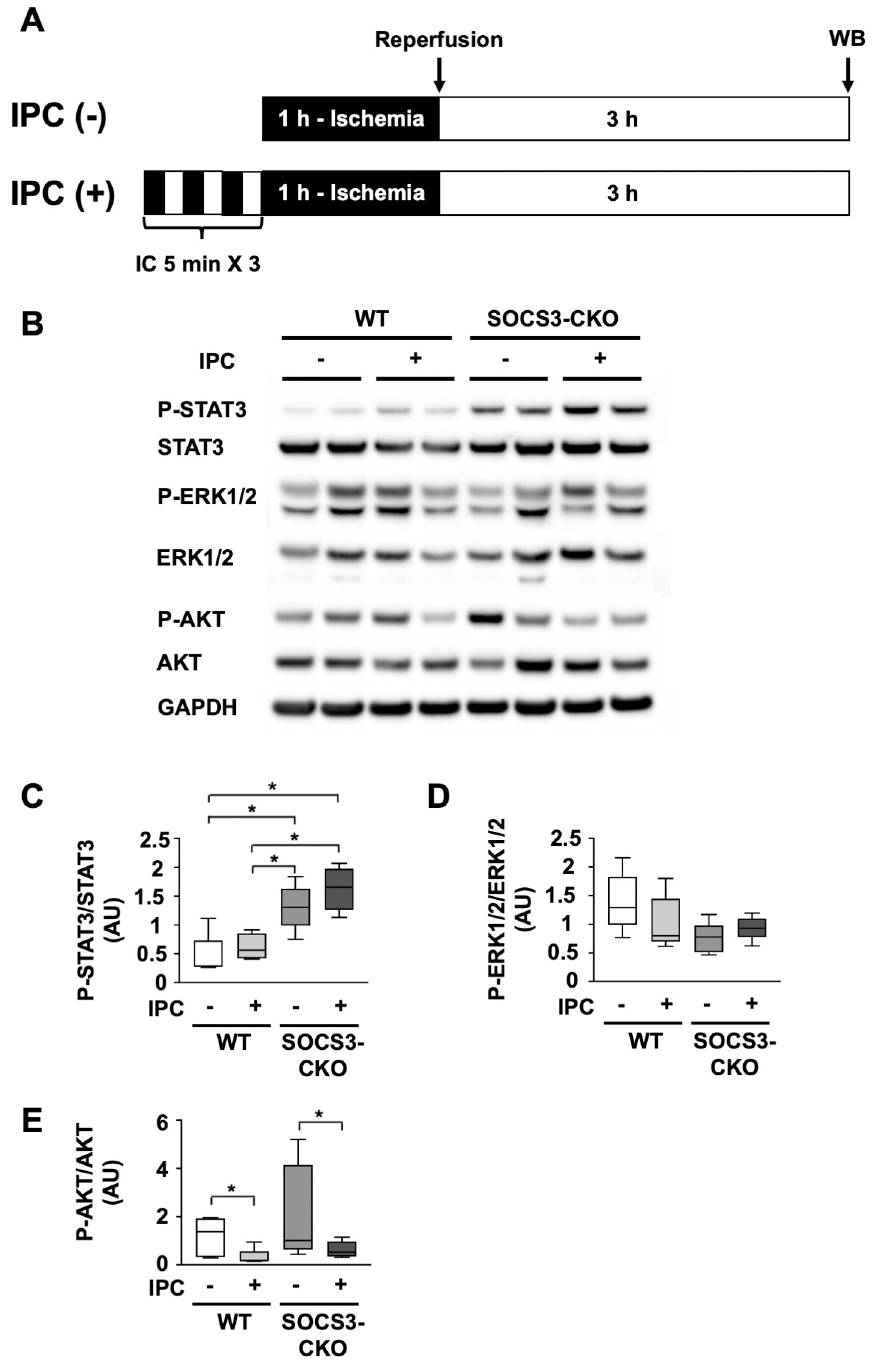
Fig 4. Activation of cardioprotective signaling molecules by ischemic preconditioning in myocardial I/R injury. ( A) Schematic illustration depicting the experimental protocol. IPC was performed with three cycles of 5-min ischemia and 5-min reperfusion. The LAD coronary artery was occluded for 1 h, and then reperfused for 3 h. (B) Total cell lysates were prepared from heart tissue obtained at 3 h after I/R from WT mice with or without IPC, and from SOCS3-CKO mice with or without IPC. Lysates were blotted with antibodies raised against phosphorylated STAT3 (P-STAT3), total STAT3, phosphorylated ERK1/2 (P-ERK1/2), total ERK1/2, phosphorylated AKT (P-AKT), total AKT, and GAPDH. ( C) , (D) , and (E) Box-and-whisker plots represent quantitative differences in P-STAT3, P-ERK1/ 2, and P-AKT expression (n = 4–5 per group). � p < 0.05 (Wilcoxon rank-sum test). I/R, ischemia reperfusion; IPC, ischemic preconditioning; LAD, left anterior descending; AU, arbitrary units; GAPDH, glyceraldehyde 3-phosphate dehydrogenase.